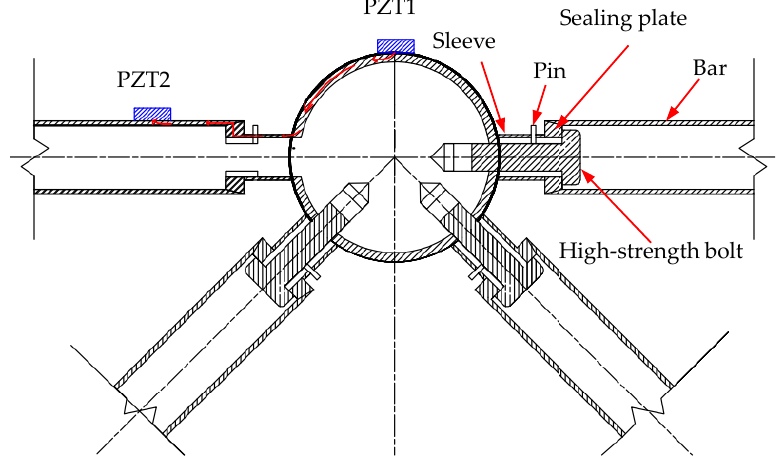
Figure 3. Energy transmission in bolted spherical joint connection.